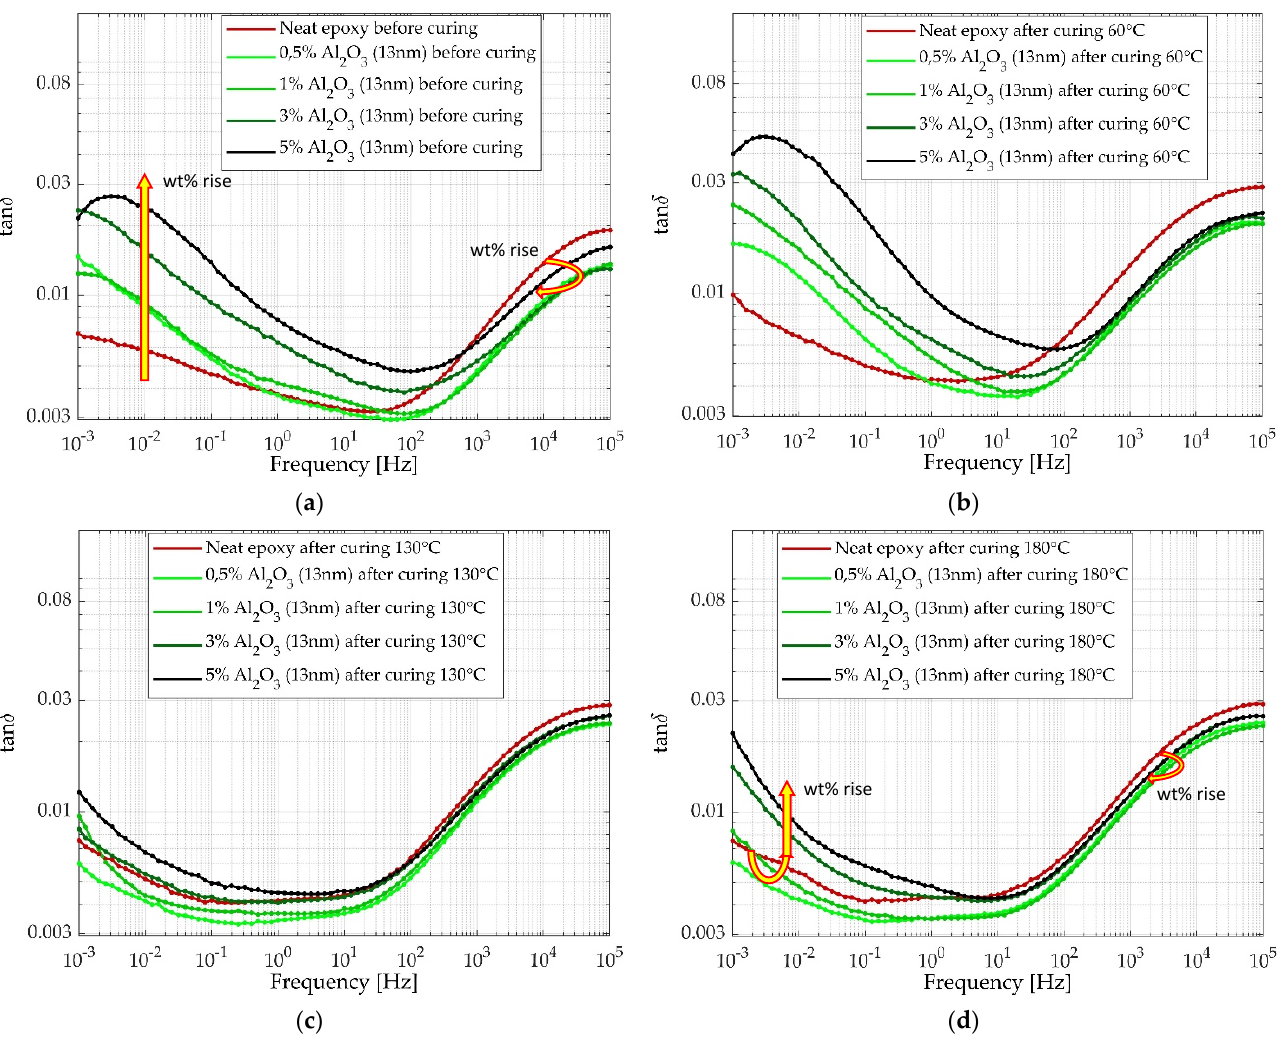
Figure 7. Broadband dielectric loss factor tan δ ( f ) characteristics for samples with Al 2 O 3 , with particles of 13 nm: ( a ) new, before curing, ( b ) after thermal curing at 60 °C, ( c ) after thermal curing at 130 °C, ( d ) after thermal curing at 180 °C.